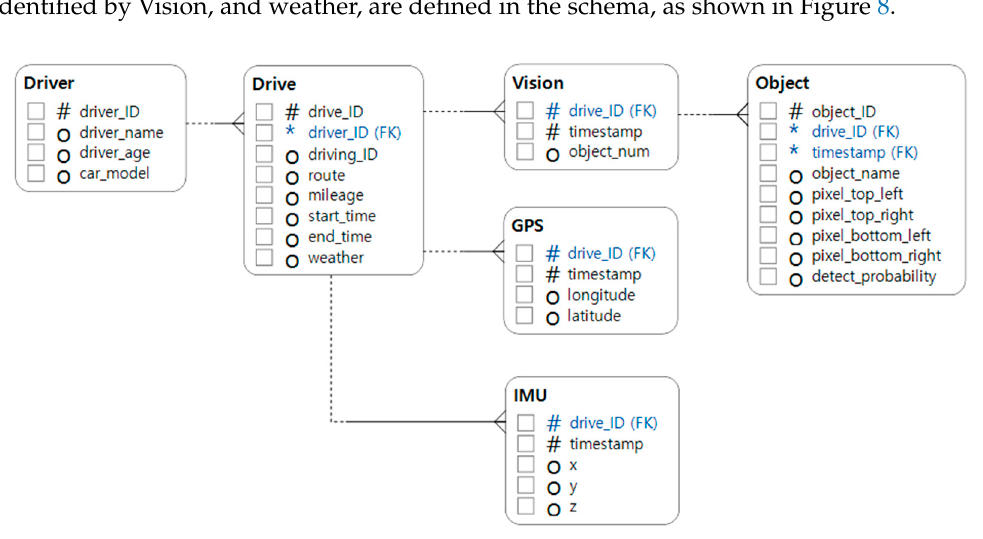
Figure 8. Schema of the RDBMS.